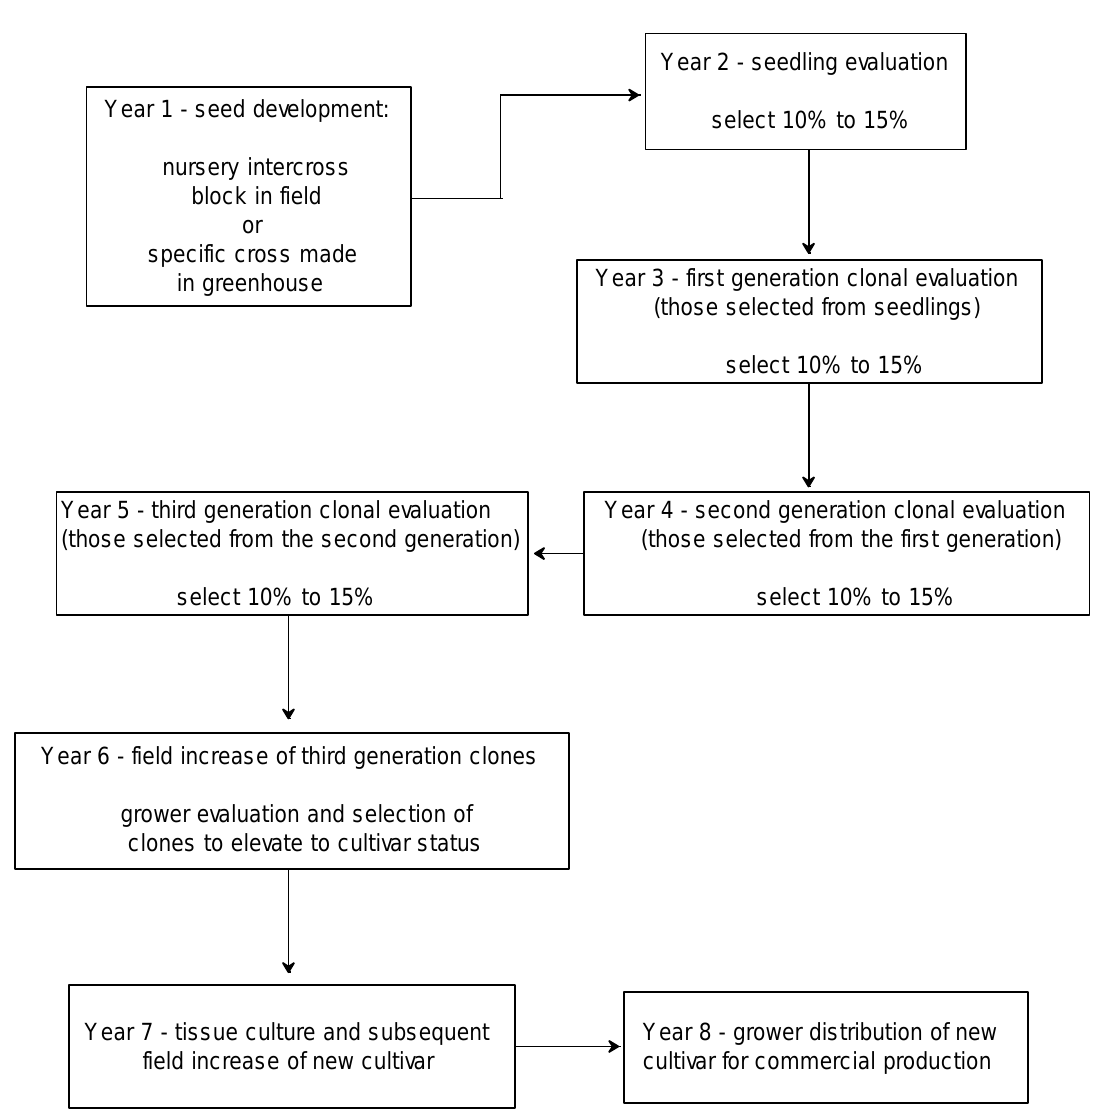
Figure 2. Typical breeding cycle for horseradish and duration required to produce new a new clonal cultivar. Horseradish roots are selected based on lack of internal root discoloration, high root biomass and quality (smooth root surface with few fine roots), horizontal root development in the soil opposed to vertical growth, and high set root production.